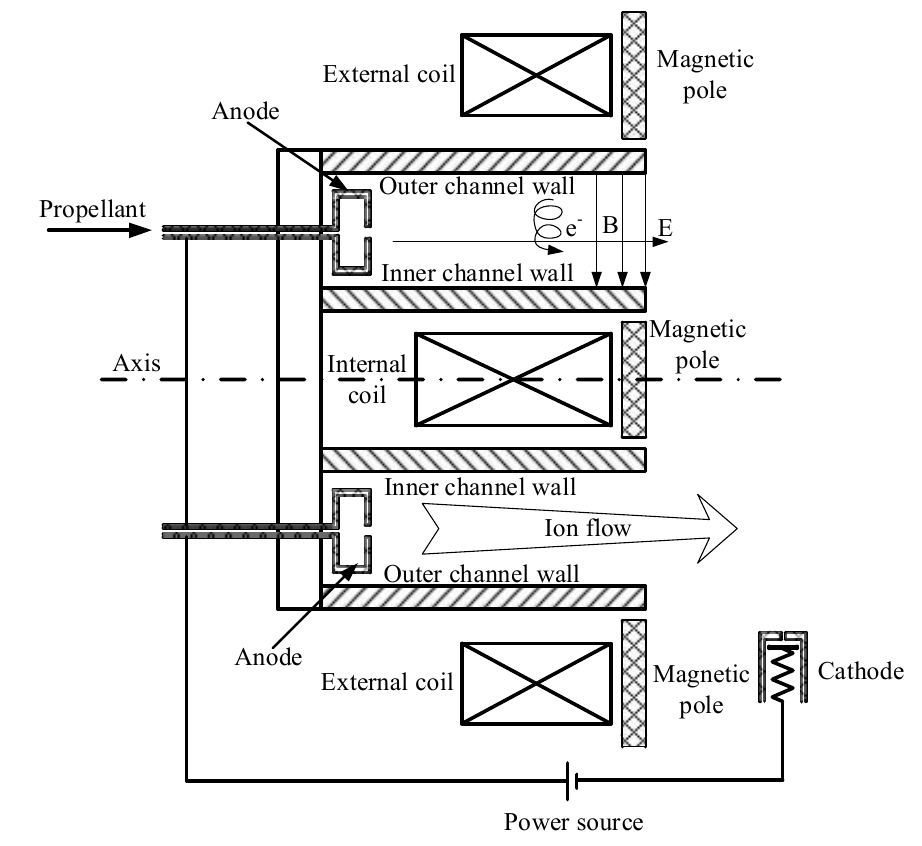
Figure 1. Geometry structure of the PIC model in radial-azimuthal plane.